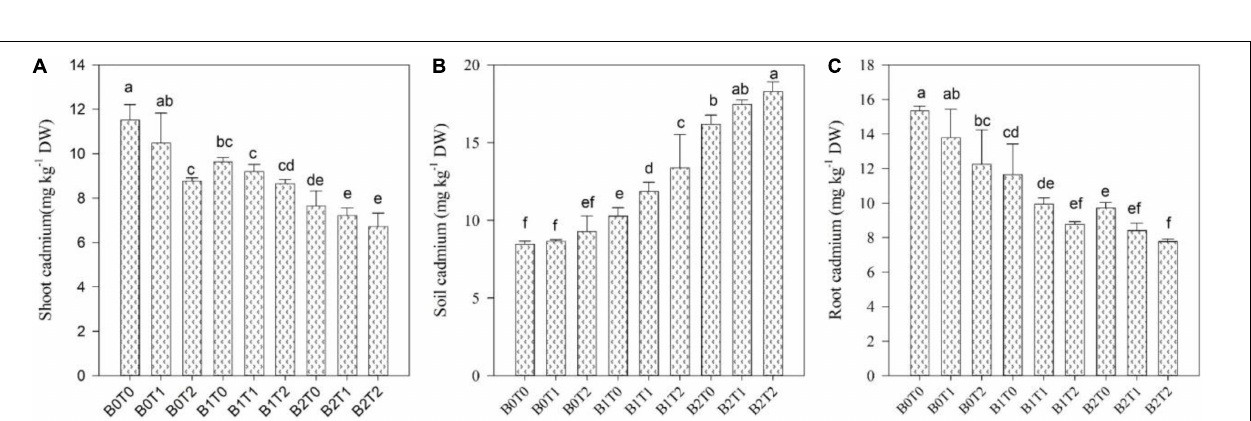
Figure 6 | Effect of combined application of TU and BC on (A) Cd concentration in shoot, (B) Cd concentration in soil, and (C) Cd concentration in root grown under Cd contamination. Values are averages ± SD ( n = 3). Different statistical letters represent significant differences in values between treatments ( p < 0.05). TU, thiourea; BC, biochar; T 0 = 0 mg L − 1 ; T 1 = 600 mg L − 1 ; T 2 = 600 mg L − 1 ; B 0 = 0% w/w; B 1 = 2.5% w/w; B 2 = 5.0% w/w.